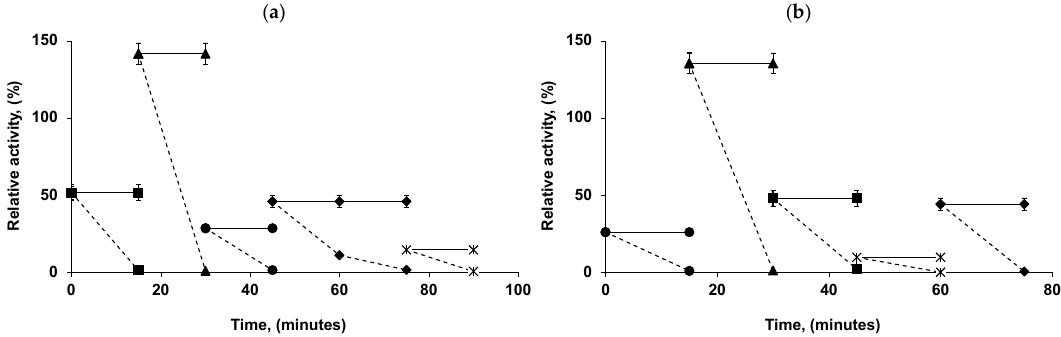
Figure 8. Activities evolution of the supernatants of the immobilization suspensions during the preparation of multi-combilipases. ( a ) Octyl-VS-CALA-TLL-CALB-PEI-LEU-RML and ( b ) octyl-VS-CALB-TLL-CALA-PEI-RML-LEU. Solid line: reference lipase solution; dotted line: supernatant. Squares: CALA; triangles: TLL; circles: CALB; rhombus: LEU and X: RML. Other specifications are described in Methods.